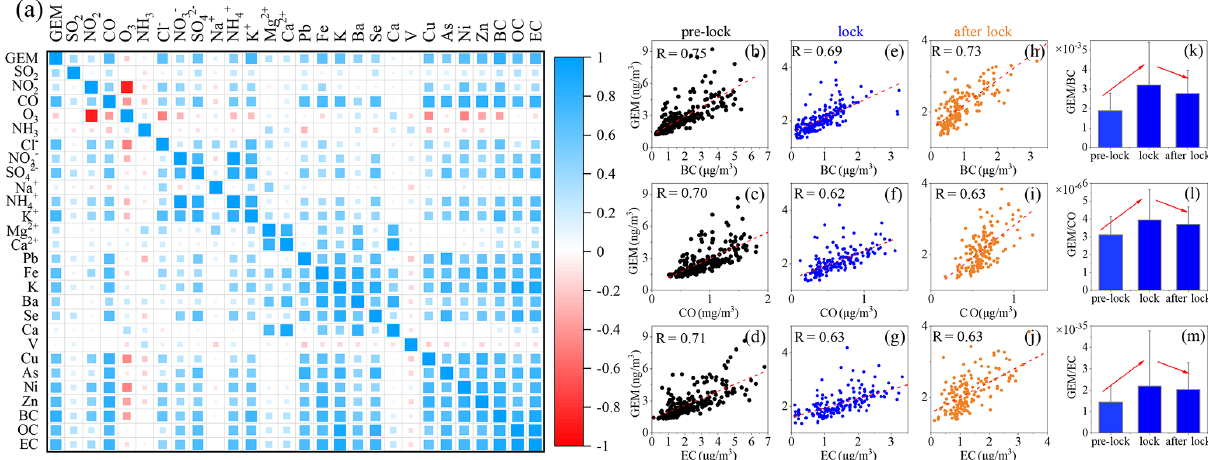
Figure 2. (a) Correlation coefficient matrix among GEM and PM 2 . 5 components and gaseous pollutants during the whole study period. Relationship between GEM and BC, CO, and EC (b–d) before, (e–g) during, and (h–j) after the lockdown. (k–m) The change in GEM / BC, GEM / CO, and GEM / EC ratios before, during, and after the